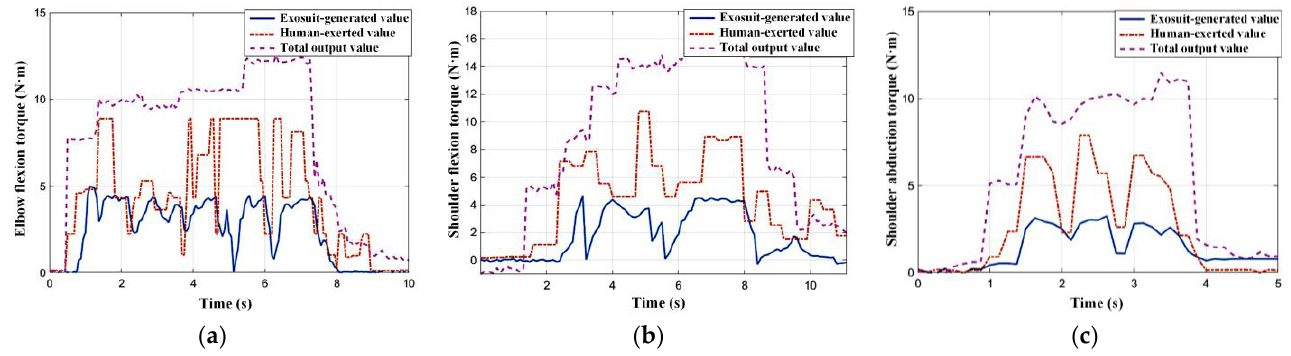
Figure 11. Variations of different torques in each motion mode: ( a ) torque curves for elbow static flexion; ( b ) torque curves for shoulder static flexion; ( c ) torque curves for shoulder static abduction.